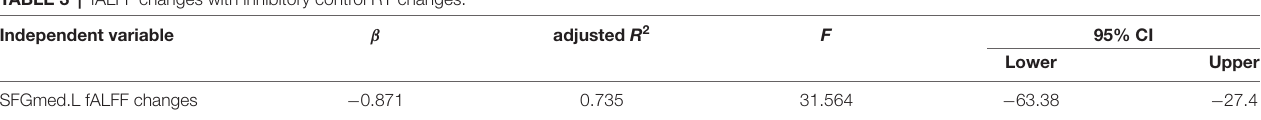
TABLE 3 | fALFF changes with inhibitory control RT